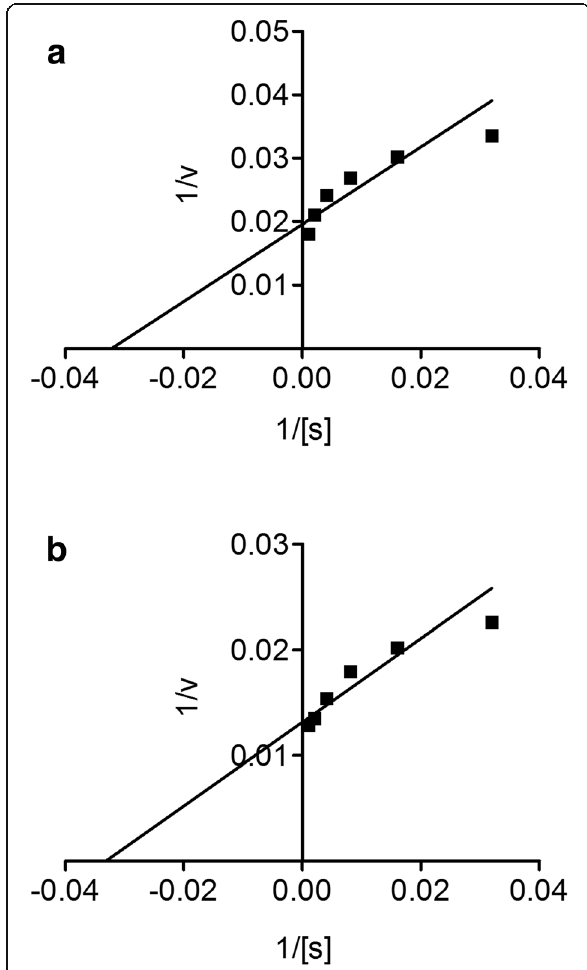
Fig. 9 Lineweaver-Burk plots representing the reciprocal of initial α - glucosidase velocity versus the reciprocal of substrate concentration in the presence of different concentrations of ON-Cr ( a ) and the positive control, galantamine ( b